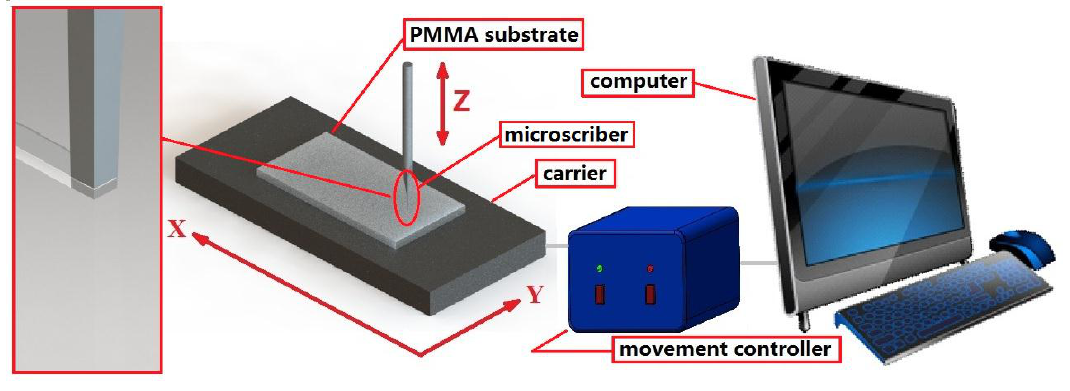
Figure 6. Fabrication schematic diagram.